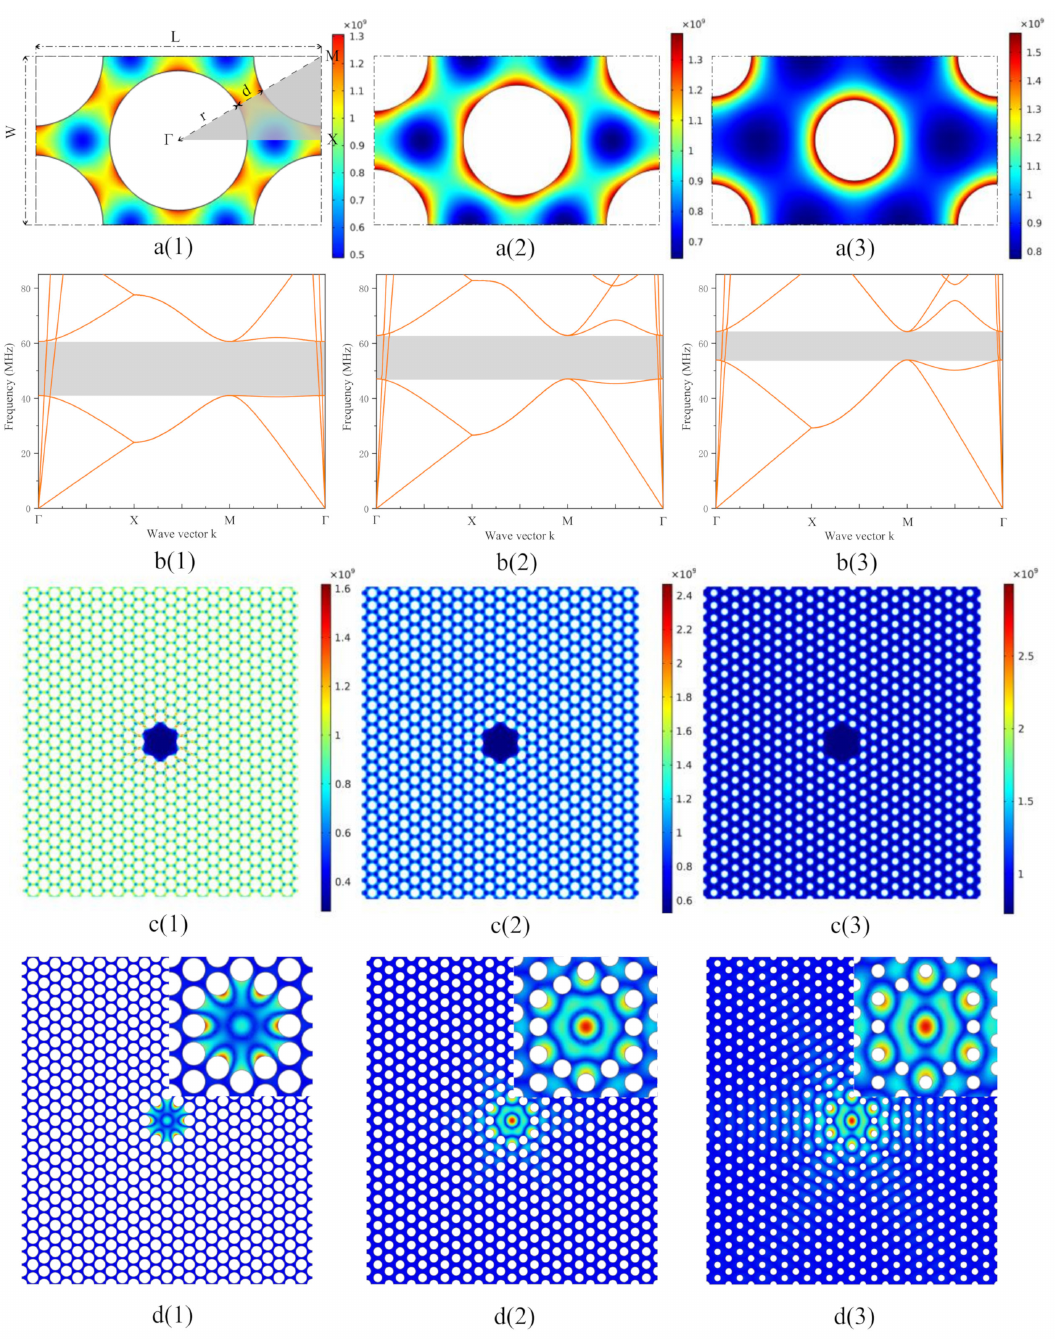
Figure 1. a(1) – a(3) Three periodic primitive cells with different interval gaps d as: 1 µ m, 2 µ m and 3 µ m, along with the simulation results of the stress redistribution. The grey triangular area interprets the collective first Brillouin zone. b(1) – b(3 ) Quasi-bandgaps are opened, marked with grey area, corresponding to a(1) – a(3) respectively. c(1) – c(3) Realistic devices of finite size made up from three different triangular lattice unit cells accompanied by stress redistribution, corresponding to a(1) – a(3) respectively. d(1) – d(3) Localized vibrational shapes of the first defect modes originating from three structures, the insets amplify the central defect areas, corresponding to a(1) – a(3)